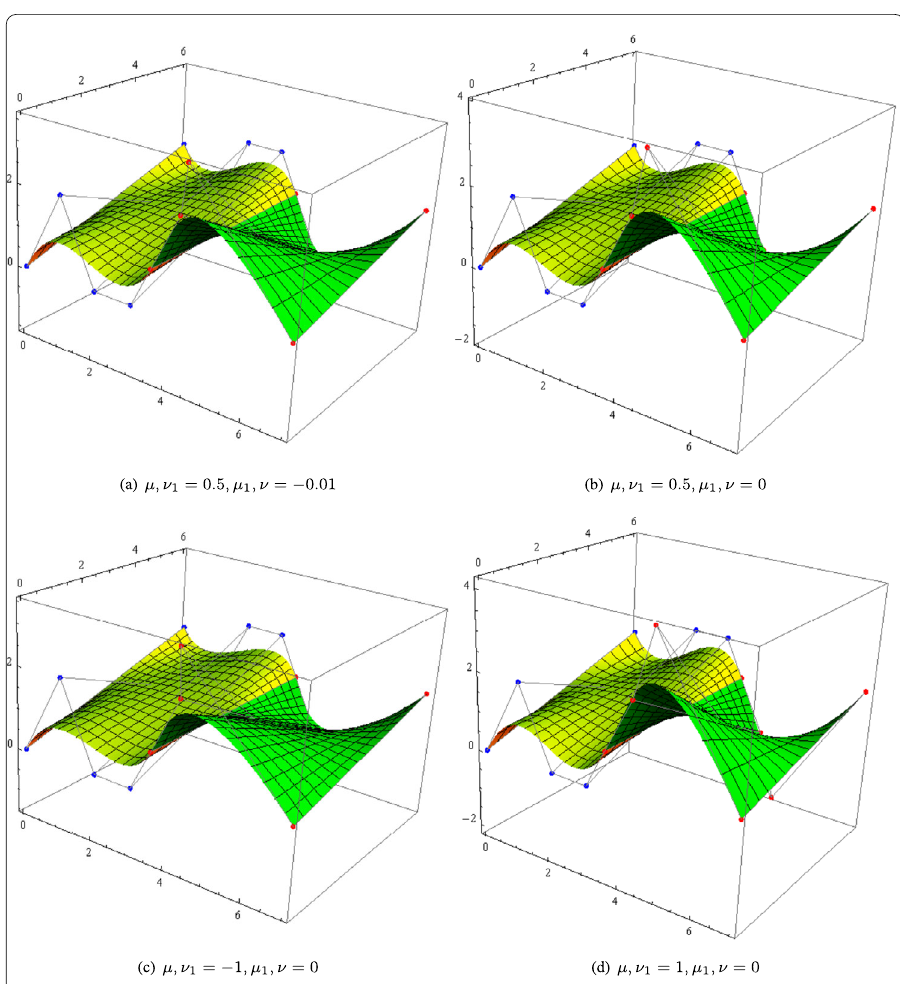
Figure 10 C 1 continuity between two GBT-Bézier ruled